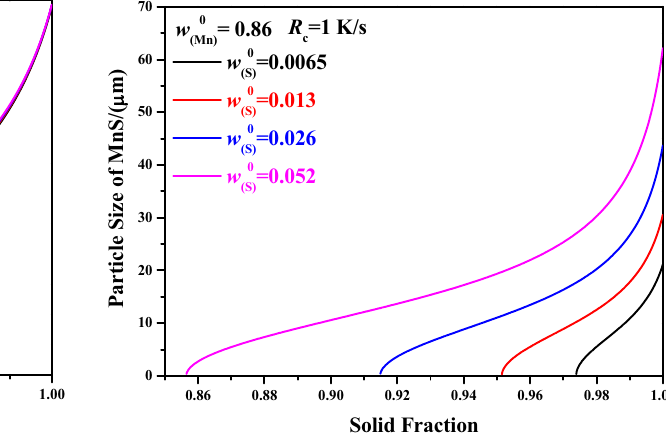
Figure 4: Effect of Mn concentration on the particle size of MnS inclusion.